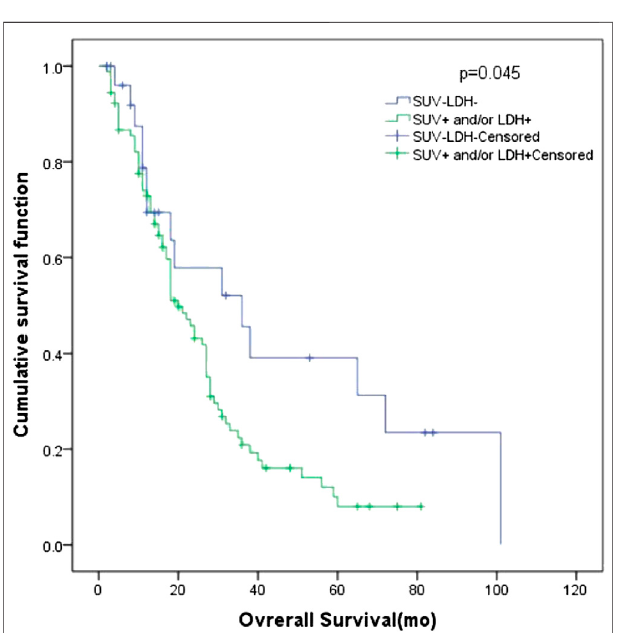
FIGURE 3 | Survival curves of SUV max of different primary tumor and LDH in 118 patients with SCLC.